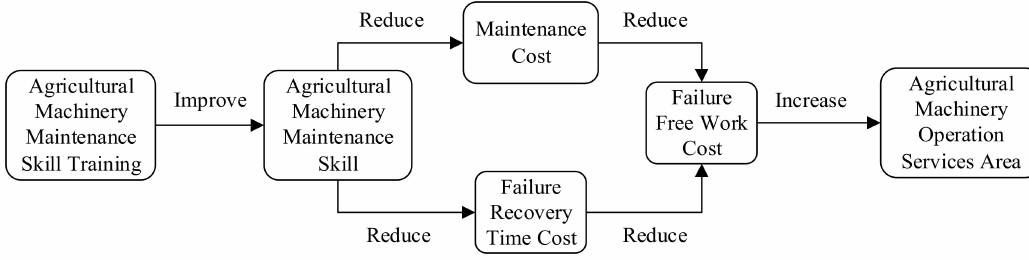
Figure 1. Theoretical